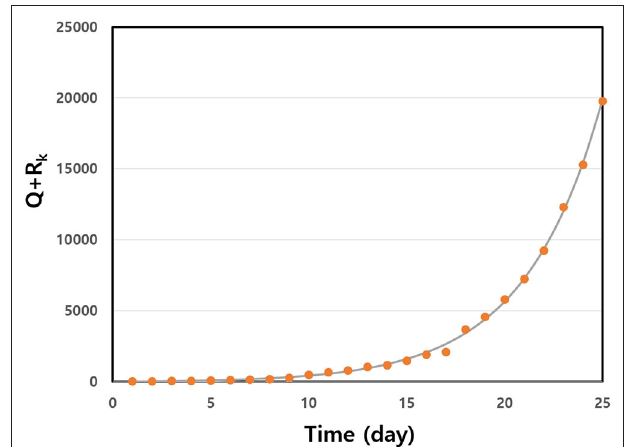
FIGURE 1 | Q + R K data were fitted to a non-linear least squares fit early in the outbreak as a function of time for Germany. The solid line is from fitted data, and the solid circles are the real data. We obtained fitting parameters a = 9.62 and b = 0.25.